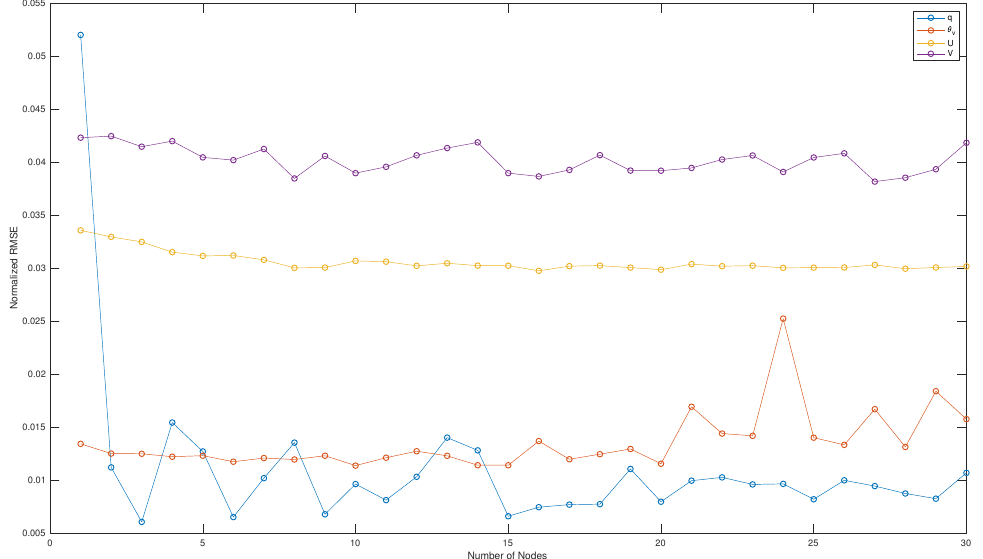
Figure A1. Illustration of the impact of incrementally adding hidden nodes to the base ANN described in Appendix A on model performance as quantified by normalized